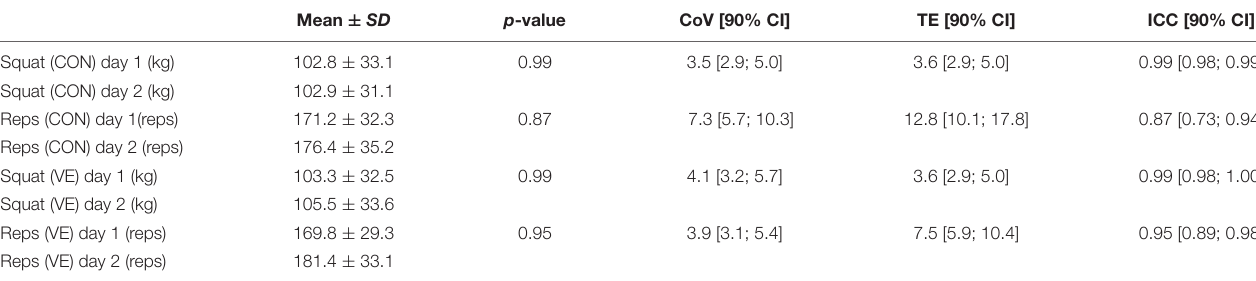
TABLE 2 | Absolute and relative day-to-day reliability values for HIFT-specific strength (1 RM squat in kg) and endurance (repetitions, reps) tests in both test settings (CON vs. VE).